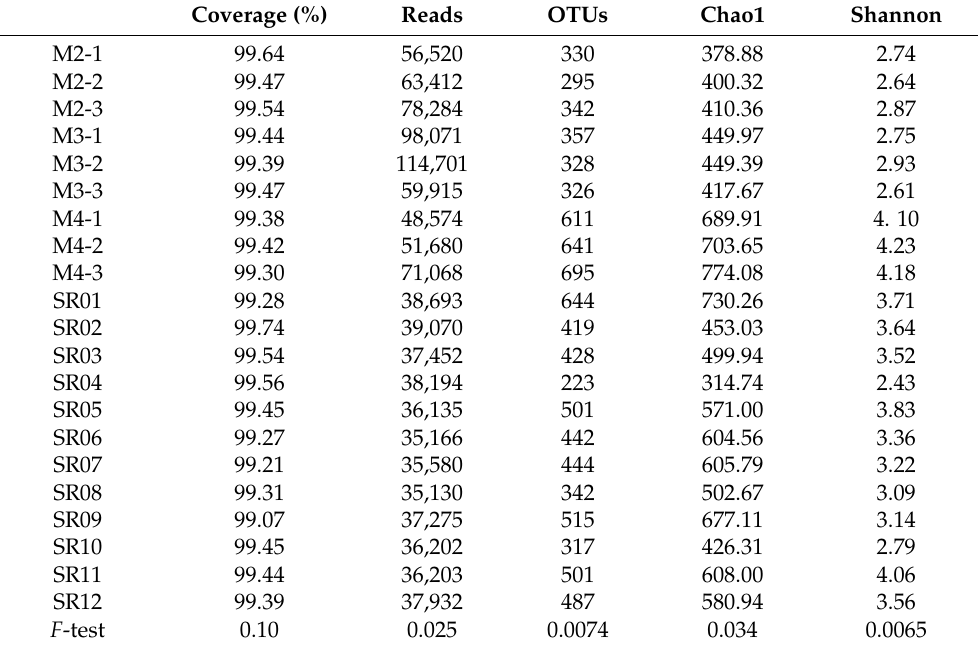
Table 4. Summary information from high-throughput sequencing data for the 21 eukaryotic